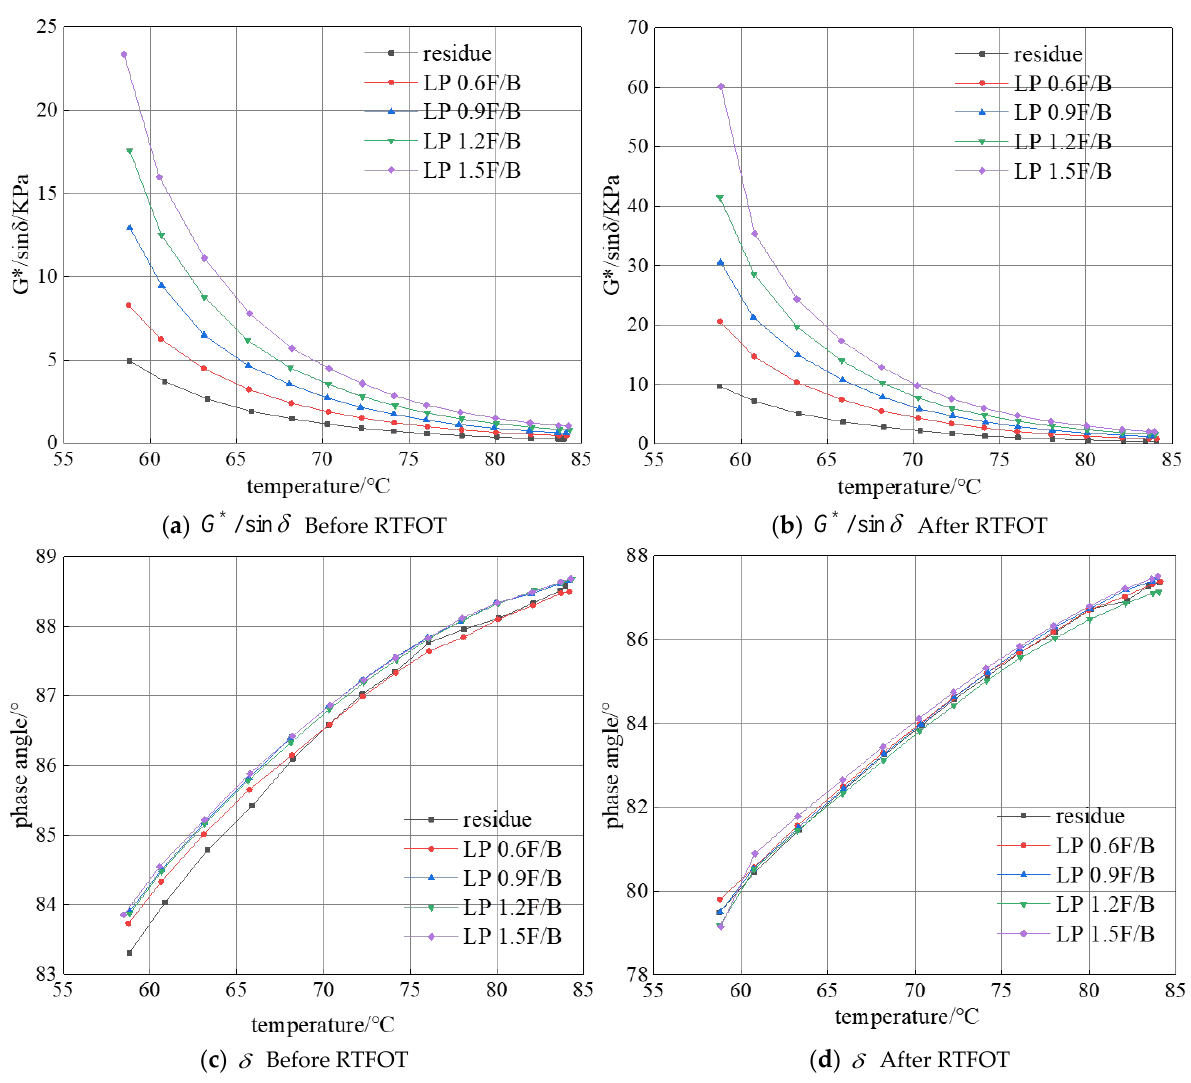
Figure 3. Temperature scanning test results of limestone powder asphalt mastics. (3) After the incorporation of three different fillers, the G ∗ / sin δ of the emulsified asphalt mastics was significantly increased, and the greater the filler content, the greater the G ∗ / sin δ of the mastics, indicating that the filler could significantly improve the resistance of the emulsified asphalt mastics to high temperature deformation. However, the addition of fillers had little effect on the δ of the mastics. The δ represents the viscoelastic compo- sition ratio of the mastics material, indicating that the viscoelastic ratio of the emulsified asphalt mastics prepared by the three fillers selected in this study was independent of the filler